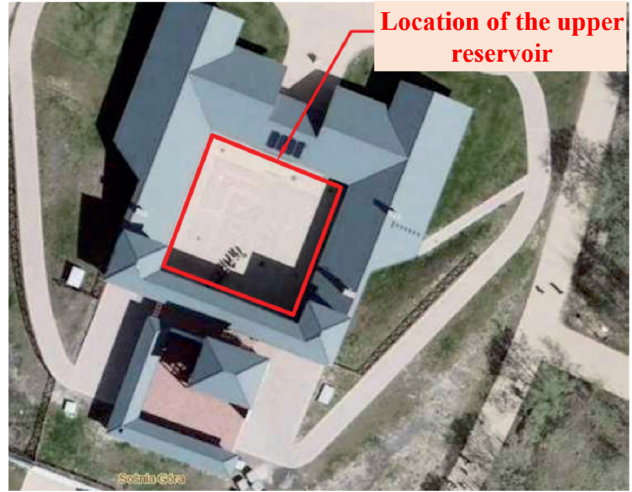
Figure 11. Location of the upper reservoir of the pumped storage power plant—the atrium of the CEEE’s building [77] (source: phot. of Janusz Moczulski, 2013); available thanks to 2013 Paweł Kojs’ permission).